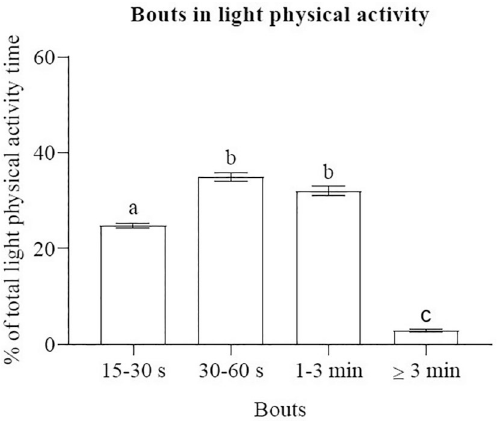
Figure 1 - Pattern of light physical activity in adolescents according to bouts. Note: different letters = significant differences between bouts ( P <